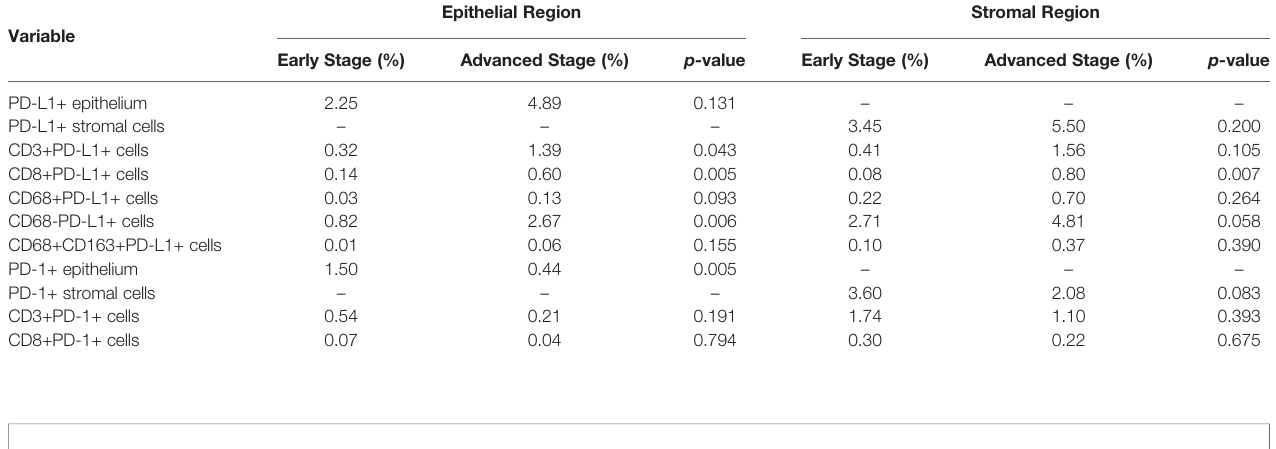
TABLE 1 | Immune composition of dMMR CRCs in epithelial and stromal regions across tumor stages.